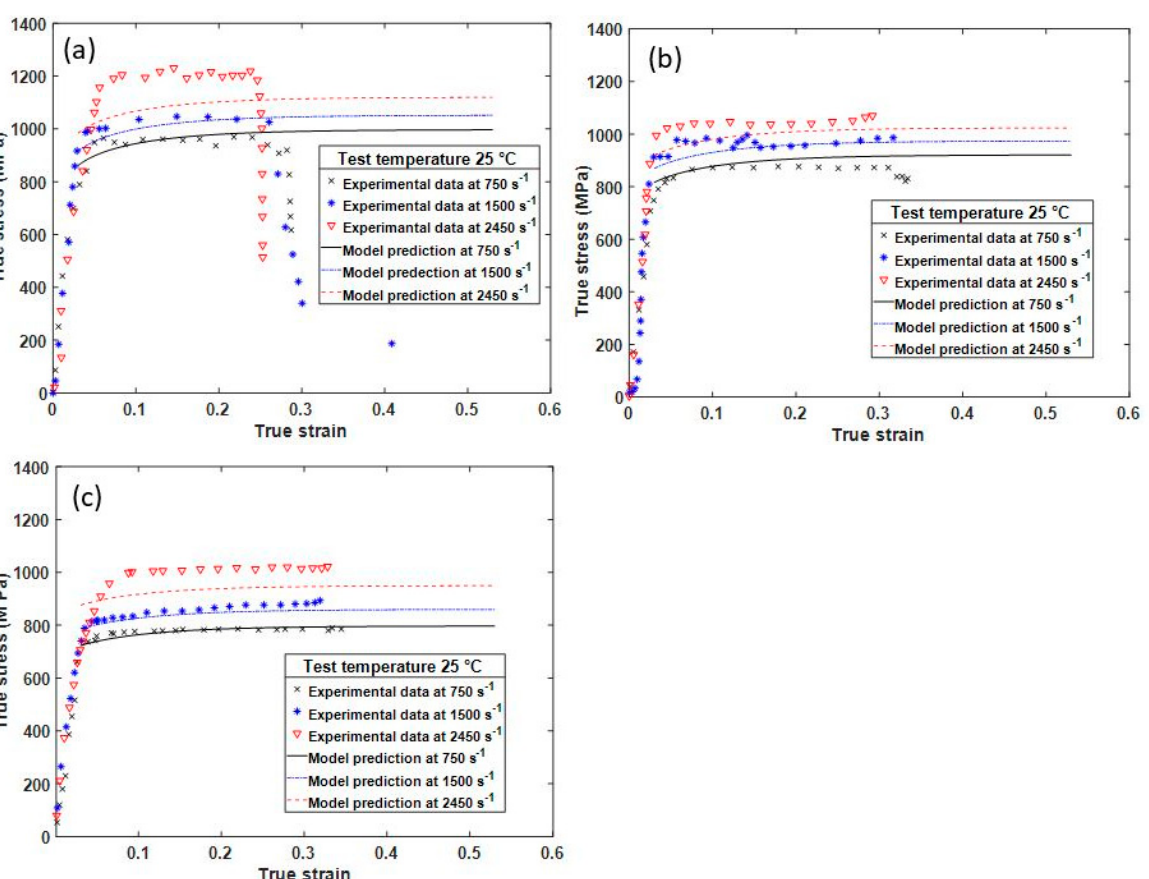
Figure 8. Experimental flow stress curves and those predicted by the model (without the viscous drag effect) at a test temperature of 25 °C and different strain rates for samples ( a ) C, ( b ) D, and ( c ) E.